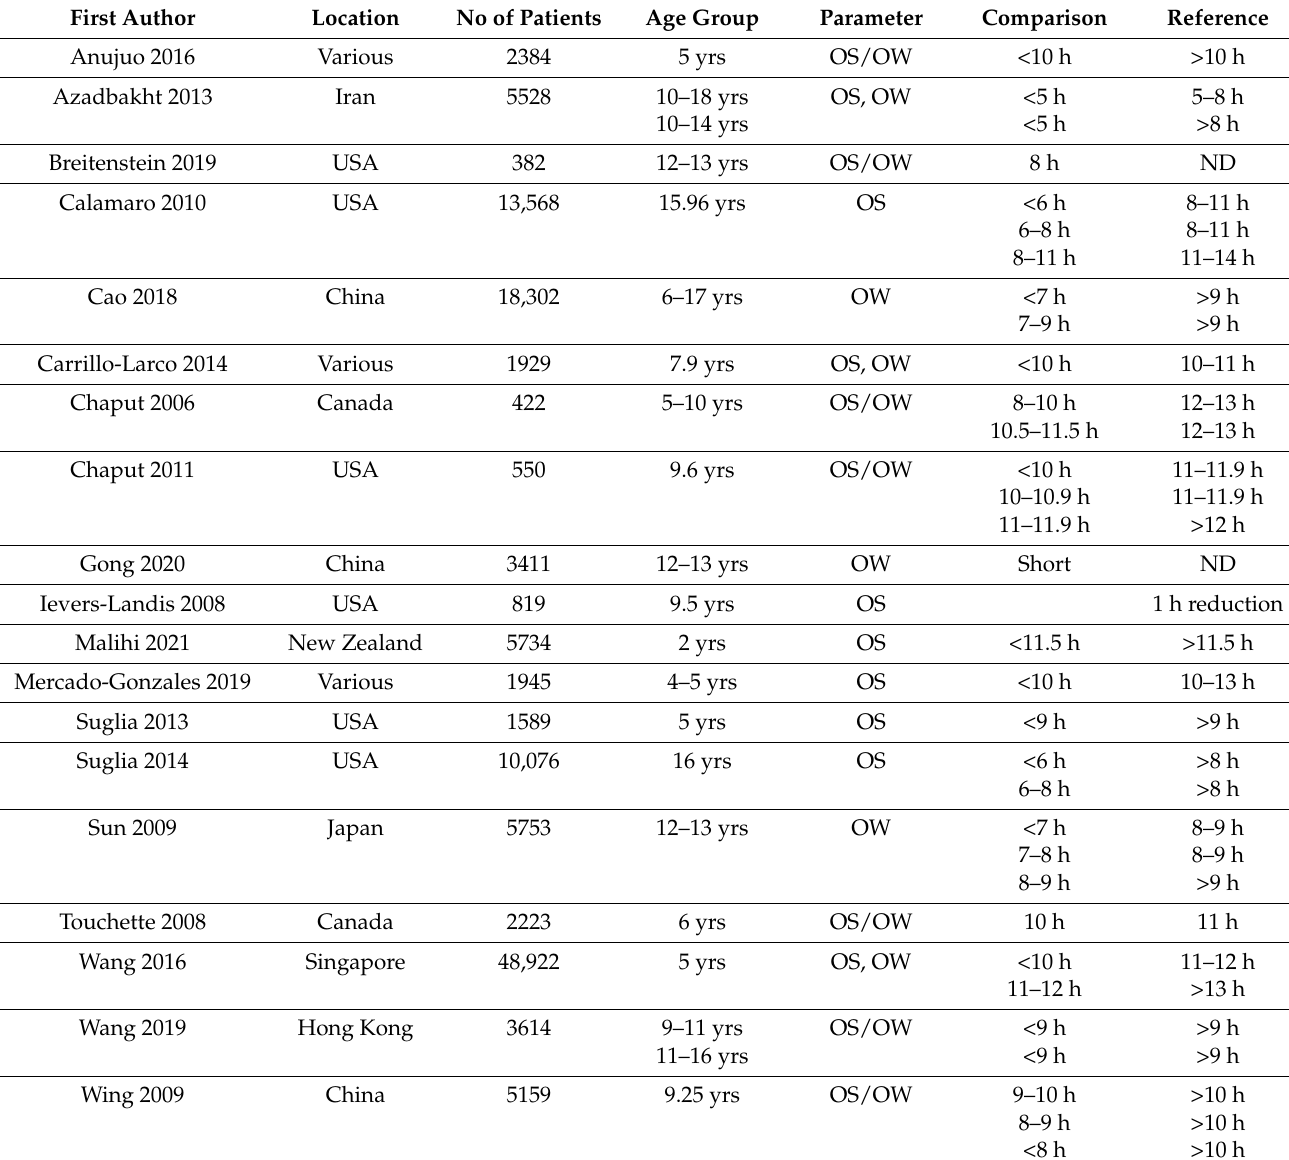
Table 1. Main characteristics of eligible